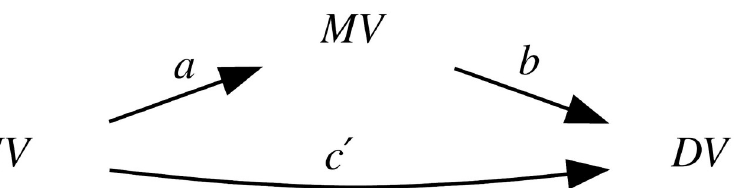
Fig 5. Visual representation of the mediation model. IV is the independent variable (here, dichotomised macroarea : inside vs outside Africa), DV is the outcome of interest (here, the various codings of tone, tone1 , tone2 or tone counts ), and MV is the mediator (here, the population frequency of one of the “derived” alleles, ASPM -D or MCPH1 -D). The average direct effect ADE = c 0 , the average indirect effect ACME = a × b , and the total effect is their sum, TE = ADE + ACME = c 0 + a × b . The coefficients a , b and c 0 are obtained from fitting two regression models simultaneously (in R formula notation): DV * IV + MV and MV * IV . These path plots are generated using Graphviz (https://graphviz. org/) as implemented by DiagrammeR::grViz in R